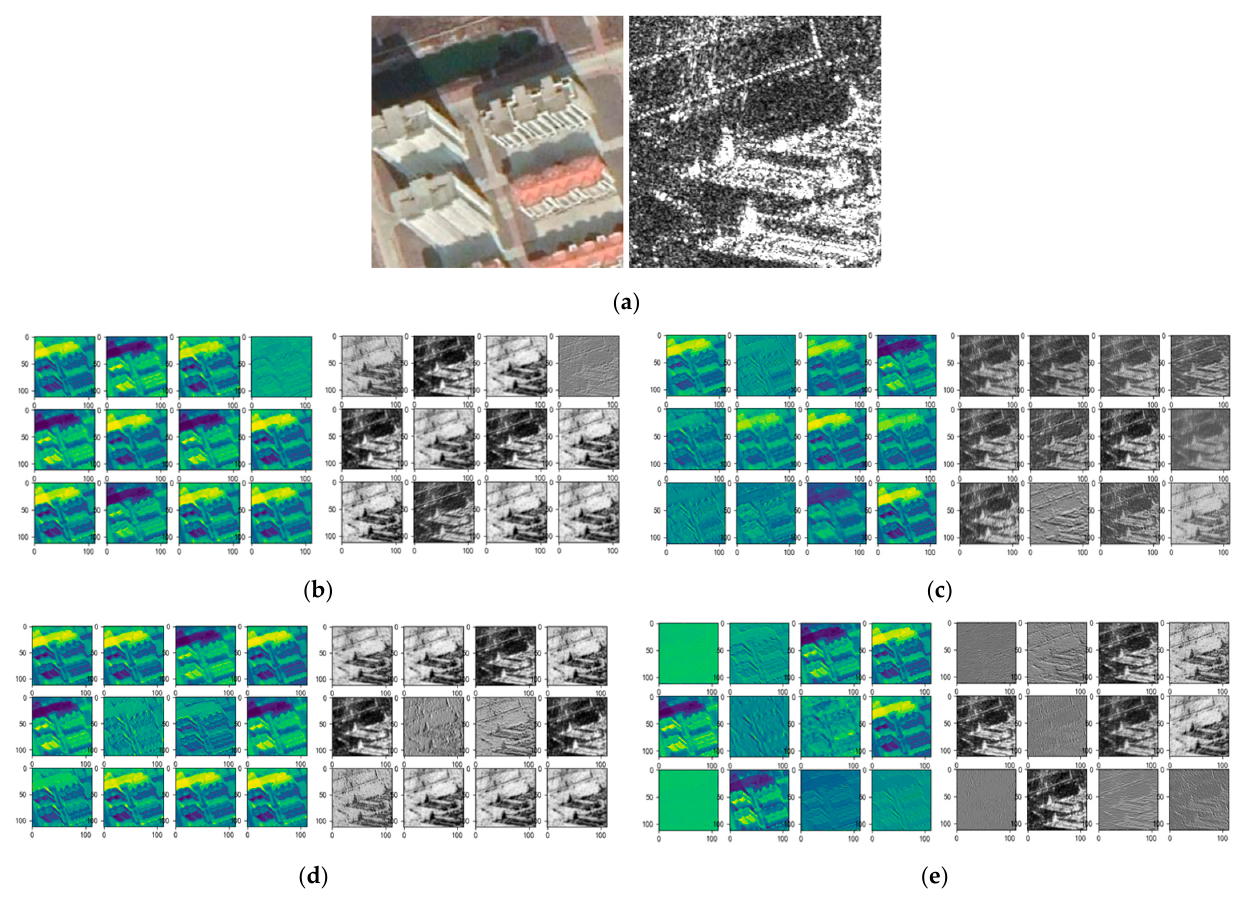
Figure 15. Feature visualization. ( a ) Example of optical and SAR remote-sensing input images; ( b ) Visualization result of ( a ) input from multi-source BYOL network; ( c ) Visualization result of ( a ) input from CMC network; ( d ) Visualization result of ( a ) input from multi-source SimSiam network; ( e ) Visualization result of ( a ) input from ImageNet pretrained network. Table 4. Overall accuracy obtained by DAN, DANN and CDAN domain adaption methods based on different pretrained